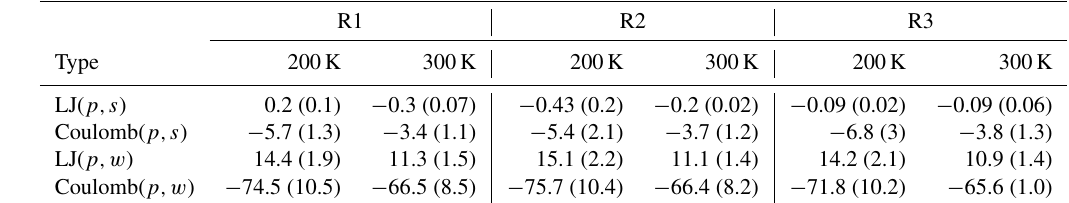
Table B1. Coulombic and Lennard-Jones (LJ) contributions of the interaction energies in selected realizations.